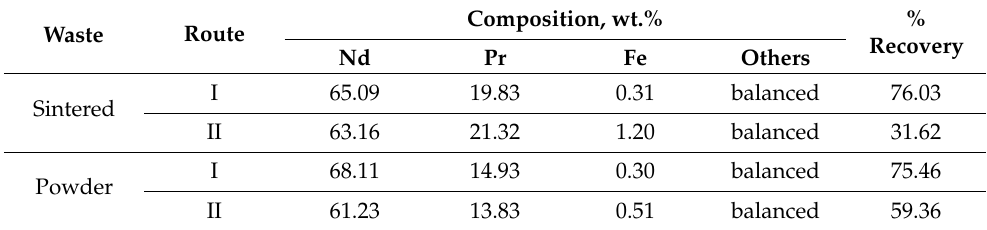
Figure 12. The XRD analyses of neodymium oxide obtained from route I: oxidative roasting and selective -leaching and route II: whole leaching. Note: OR: oxidative roasting, LC: leaching, R: roasting, P: precipitation and C: calcination. Table 3. The chemical composition of recycling products analyzed by ICP-OES.